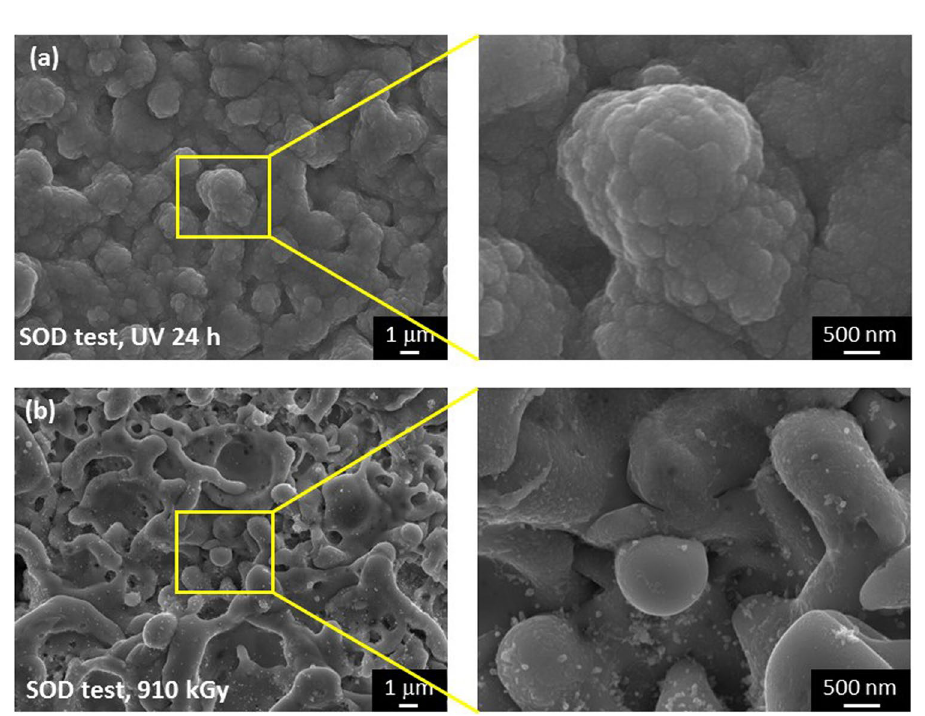
Figure 11. SEM images of the specimens with SOD addition: ( a ) specimen after 24 h of UV irradiation and ( b ) specimen after gamma-ray irradiation at a dose of 910 kGy (14 kGy·h − 1 , 65